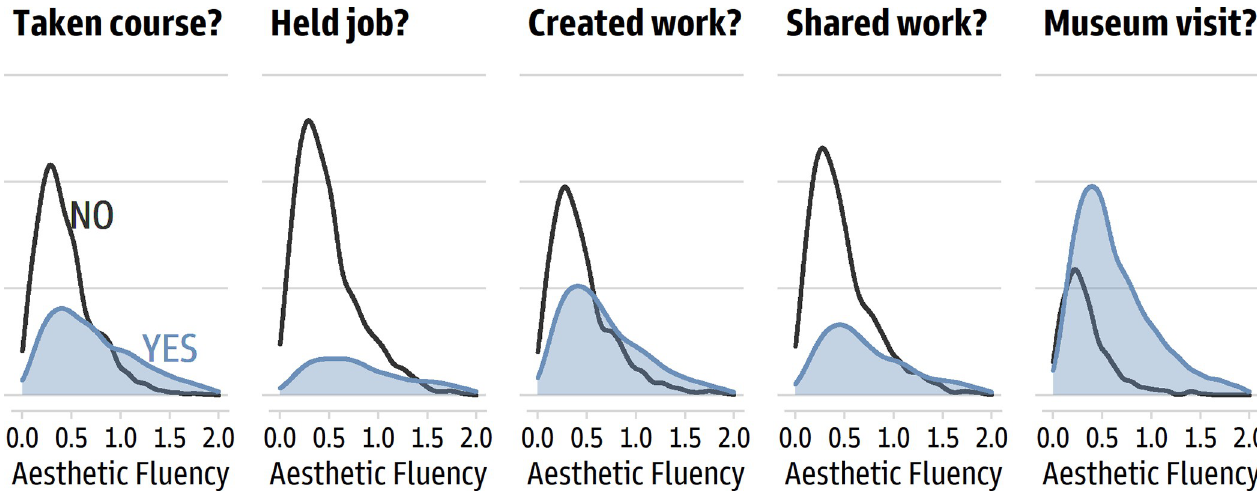
Fig 7. Differences in average aesthetic fluency scores based on art background and engagement.